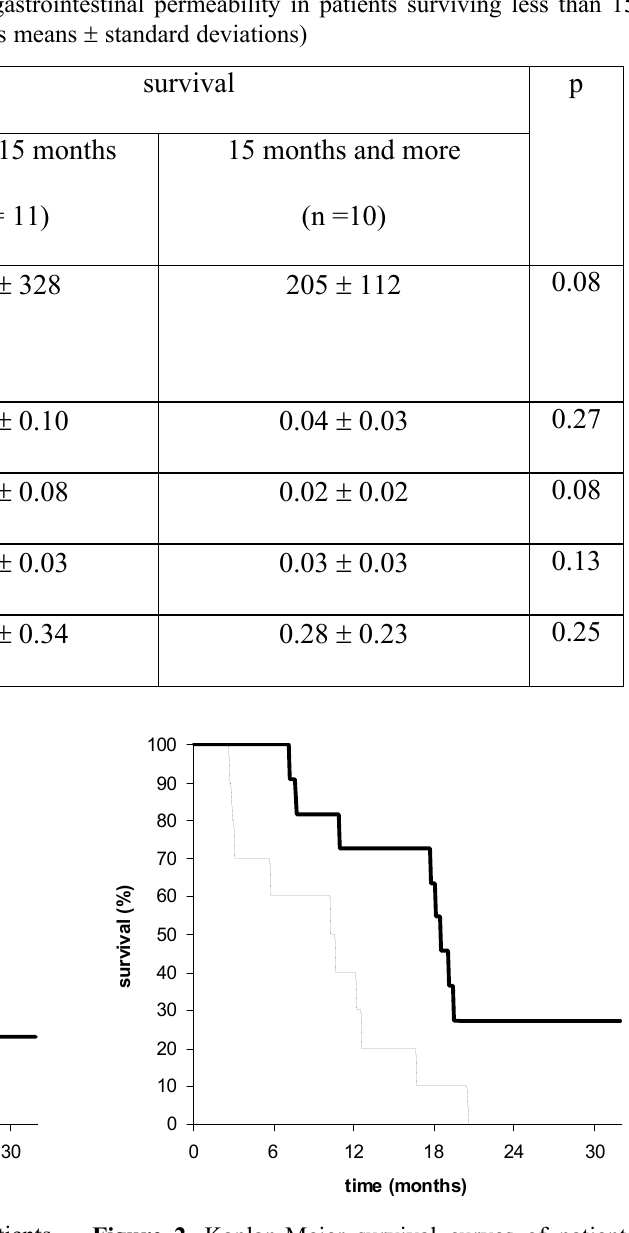
Figure 1. Kaplan-Meier survival curves of patients with sucrose/mannitol ratio below (full line) versus equal or above (dashed line) 0.04. The respective median survival was 10.6 vs. 18.4 months (log-rank test, p = 0.03).